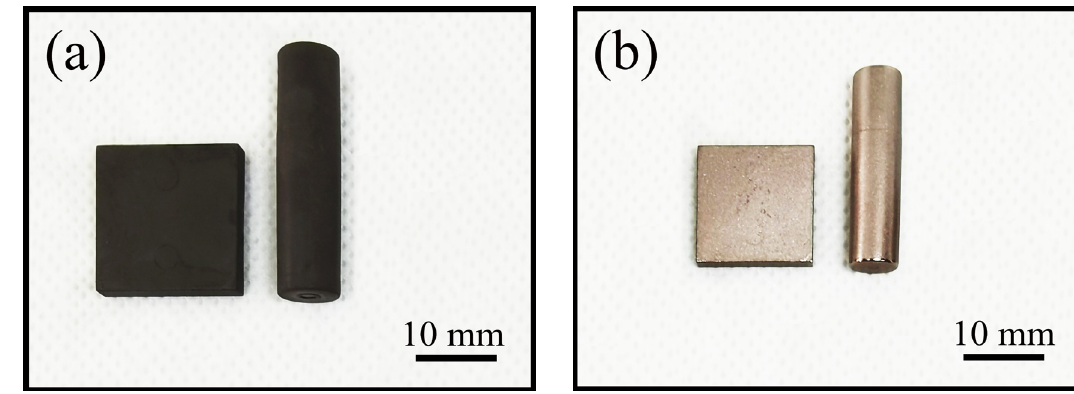
Figure 6. Test samples produced via PIM ( a ) green part; ( b ) sintered part after polish.